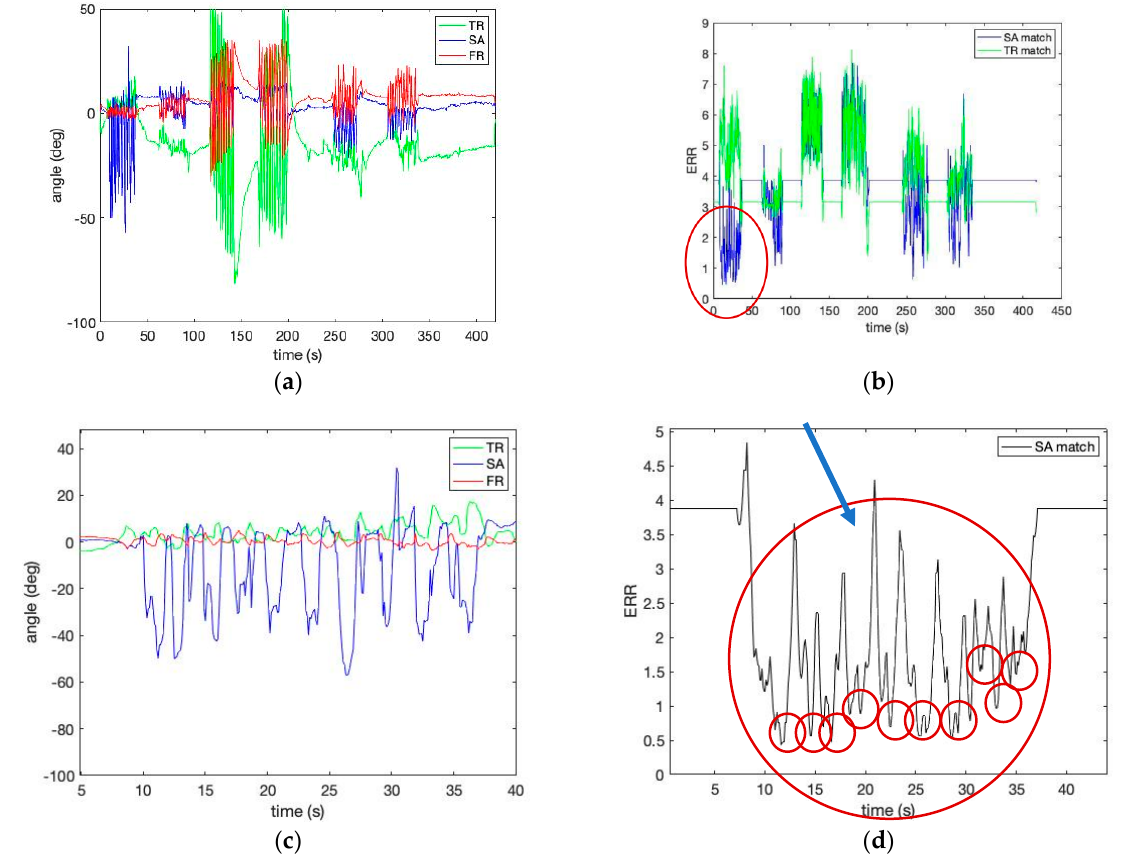
Figure 7. The estimated human motion pattern: ( a ) the measured angles for Experiment I, II, III; ( b ) the matching error level from Experiments I, II, and III calculated by the template matrices of sagittal forward flexion 60° and transverse right rotation 50°; ( c ) the measured angles for Experiment I— sagittal forward flexion 60°; ( d ) the matching error level from Experiment I (the red circled graph of Fig. 7(b)) calculated by the template matrix of sagittal forward flexion 60°. Red circles demonstrate low matching error.